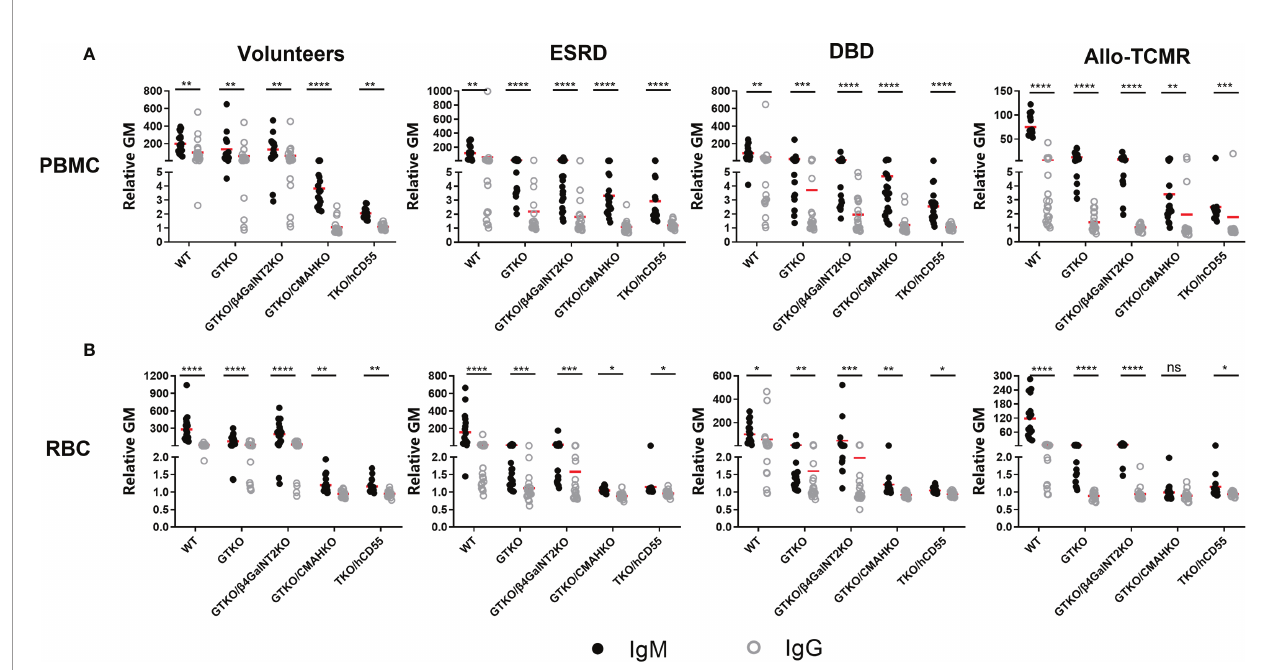
FIGURE 3 | Comparison of serum IgM and IgG binding to PBMCs and RBCs. All human subjects had lower levels of IgG binding (compared to IgM) to WT, GTKO, GTKO/ b 4GalNT2KO, GTKO/CMAHKO, and TKO/hCD55 PBMCs (A) and RBCS (B) . (*p<0.05, **p<0.01, ***p<0.005,